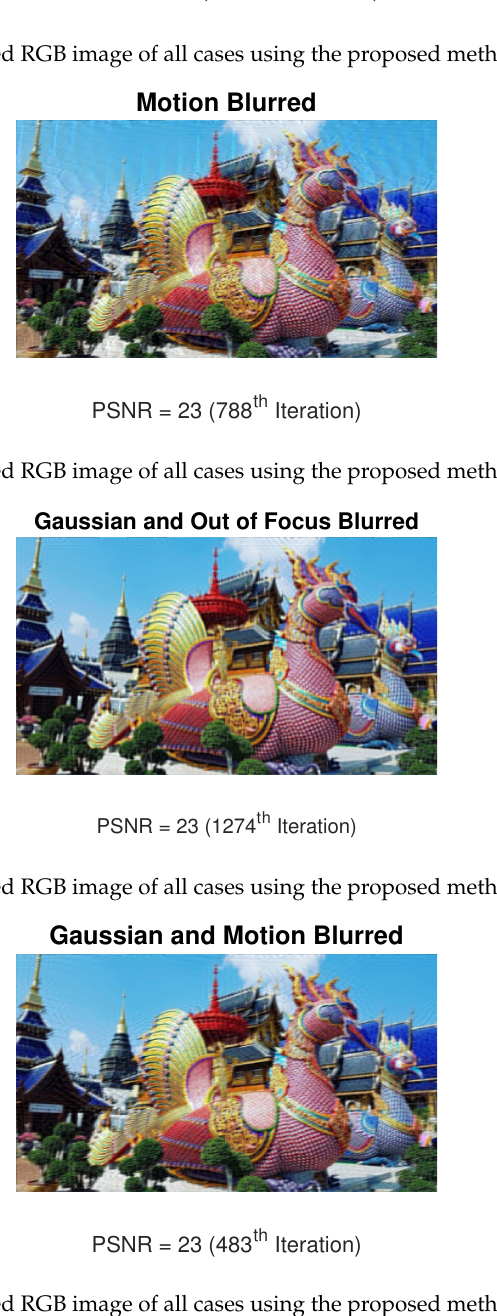
Figure 47. The reconstructed RGB image of all cases using the proposed method (2) with PSNR =